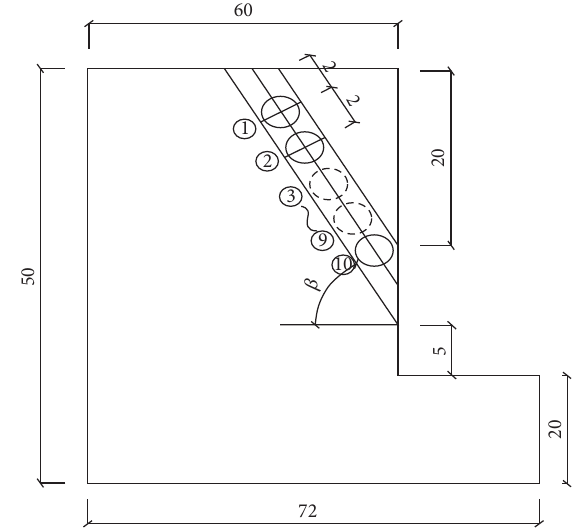
Figure 3: Schematic diagram of the calculation points (unit: